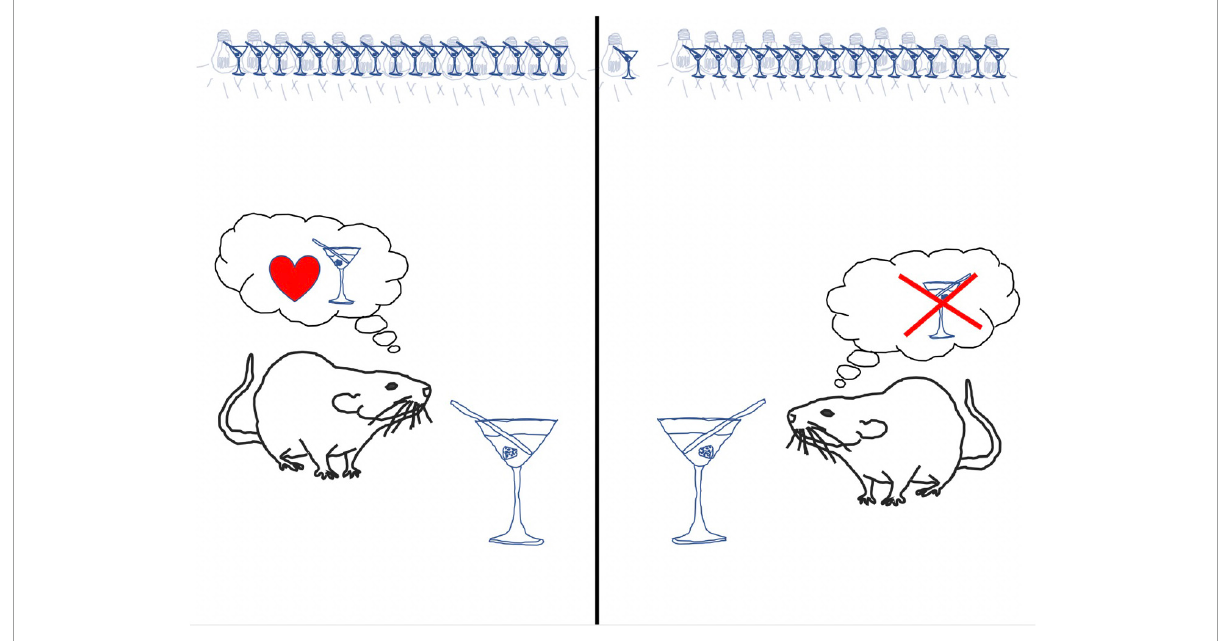
FIGURE2 Summary of study on retrieval + extinction for conditioned alcohol cue reactivity. Rats were conditioned to pairings of light and alcohol. Following conditioning, rats received either a standard extinction session, in which the light cue was repeatedly presented in the absence of alcohol, or retrieval + extinction, in which an isolated light cue was presented prior to an extinction session. Following extinction, tests for relapse-like return of conditioned responses to cues previously paired with alcohol were conducted. Conditioned responding to cues previously paired with alcohol readily returned after the passage of time and in response to alcohol odor in the rats that had received standard extinction, but not those that received retrieval +